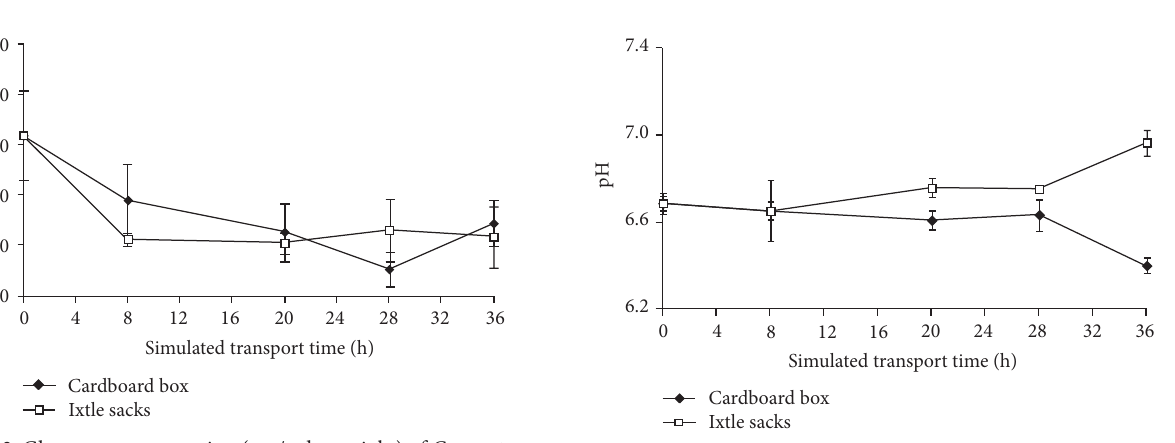
Figure 3: pH values of Crassostrea gigas oyster during in vivo transport in cardboard box and ixtle sacks. Data shown are mean of 𝑛 = 4 . Bars represent deviation